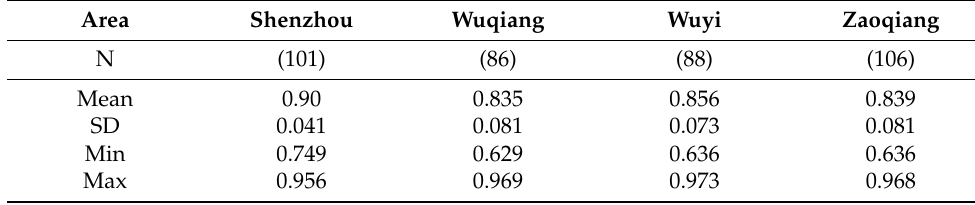
Table 4. Technical efficiency of maize production in each county.